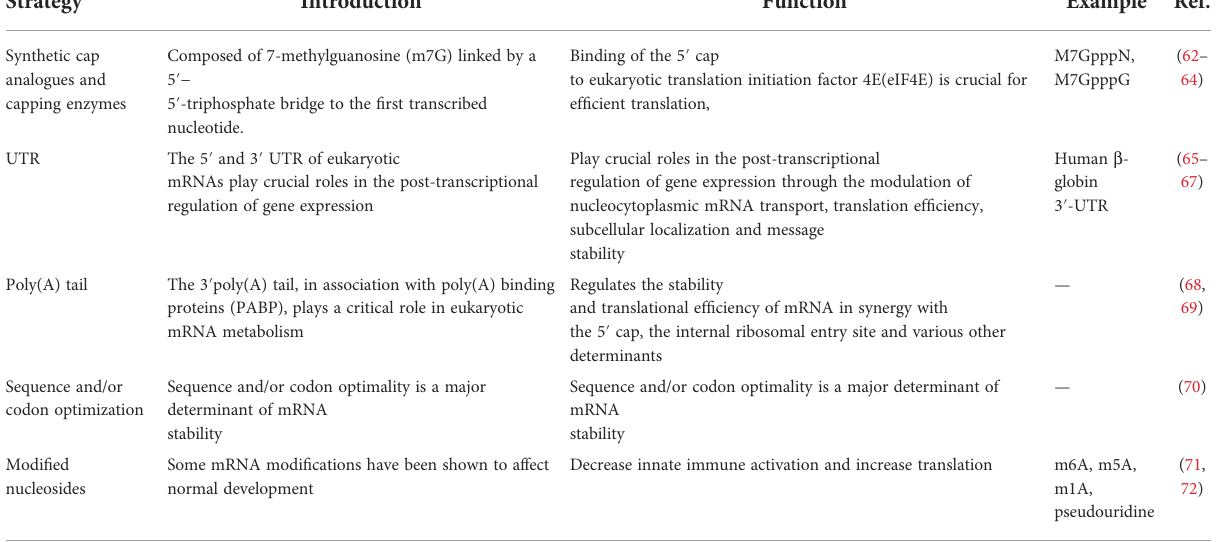
TABLE 2 Strategies for ef fi cient translation of